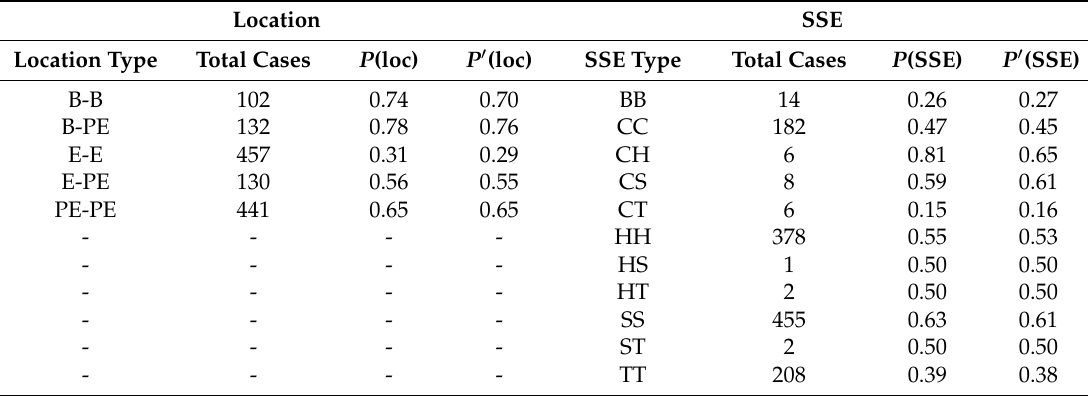
Table 2. The probabilities of the type of the location and the secondary structure element (SSE) of the mutated site to cause “large effect”. The P 1 values are calculated based on the distribution of altered | ∆∆ G | (see Equation (2)). If the total number of cases is less than 5, we assign the probability to be 0.5. See the Materials and Methods section for the definitions of SSE Type: BB, CC, CH, CS, CT, HH, HS, HT, SS, ST, and